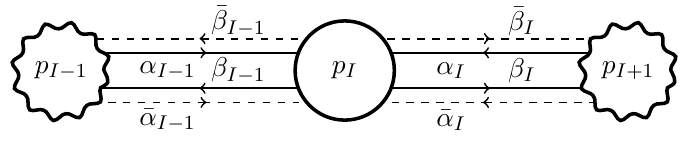
Figure 5 . A quiver diagram for a 1 / 16 BPS.